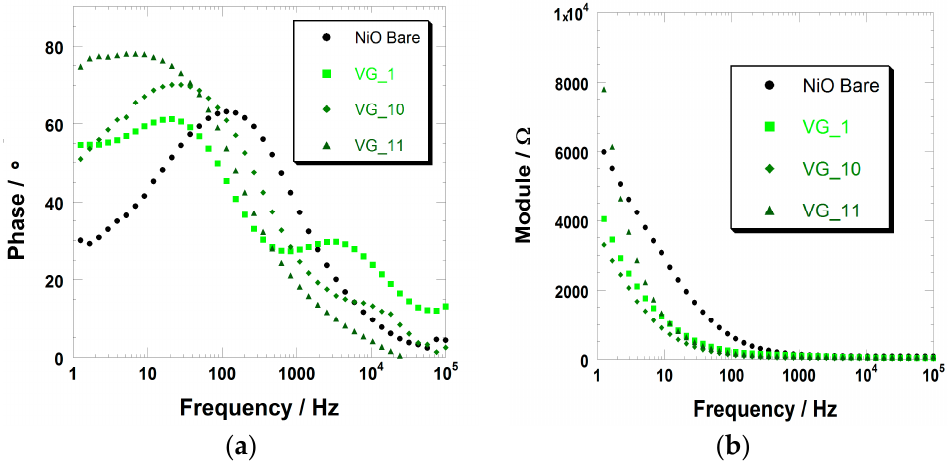
Figure 8. ( a ) Variation of the phase of the electrochemical impedance with the frequency of the potential stimulus for the cells with bare, VG_1-, VG_10-, and VG_11-sensitized NiO as the working electrode. ( b ) Variation of the impedance modulus with the frequency of stimulus for the four cells analyzed in the left frame.